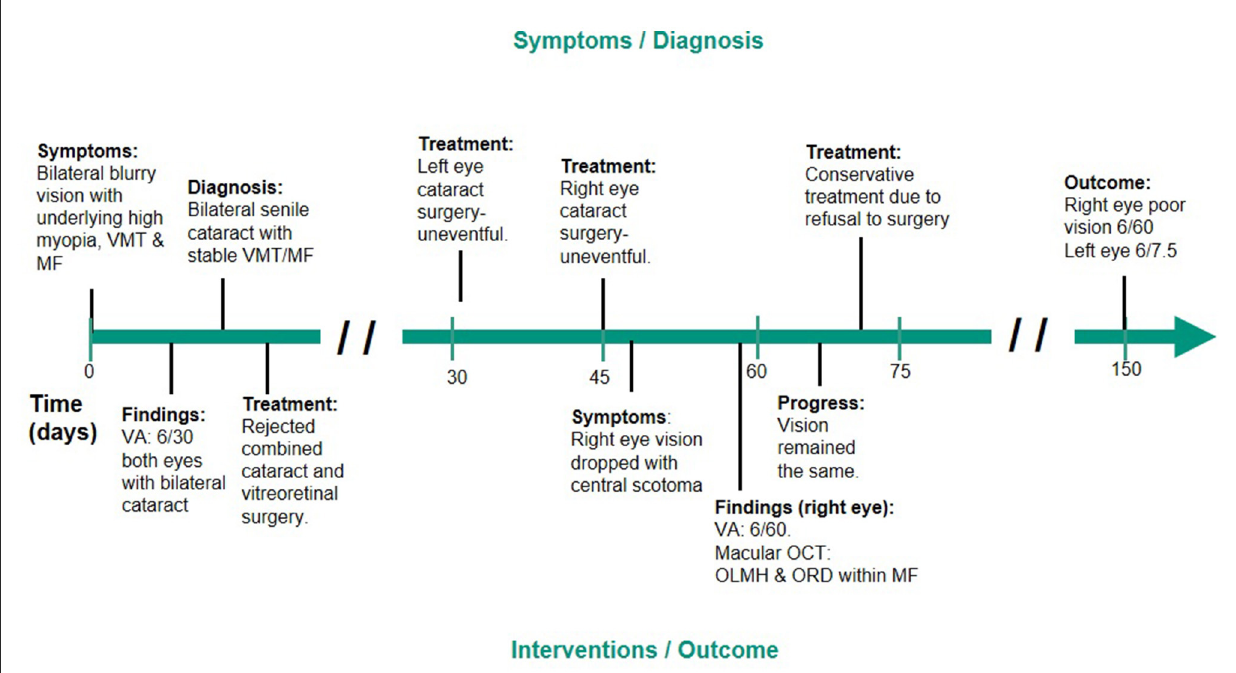
FIGURE1 Clinical timeline—A 77-year-old woman with reduced visual acuity and central scotoma after her right eye cataract surgery. VMT, vitreomacular traction; MF, myopic foveoschisis; VA, visual acuity; ILM, internal limiting membrane; OCT, optical coherence tomography; OLMH, outer lamellar macular hole; ORD, outer retinal detachment.